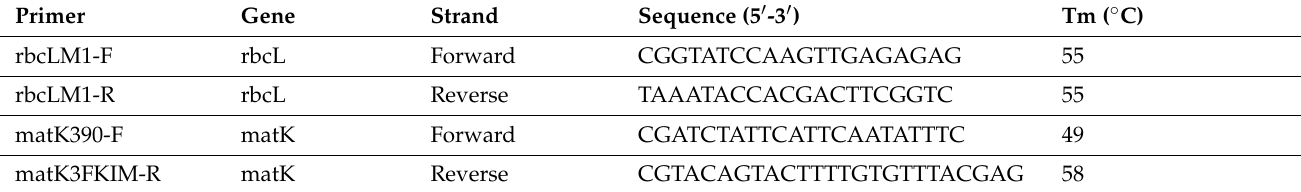
Table 5. Primer sequences. Forward and reverse orientation is defined with forward being the coding strand of the genes, all of which encode proteins. Melting temperatures are per NCBI